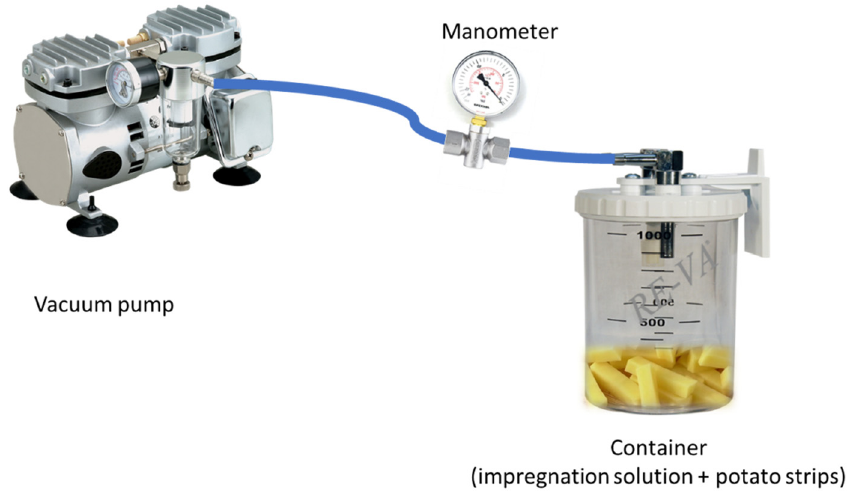
Figure 1: VI unit used in the study and its